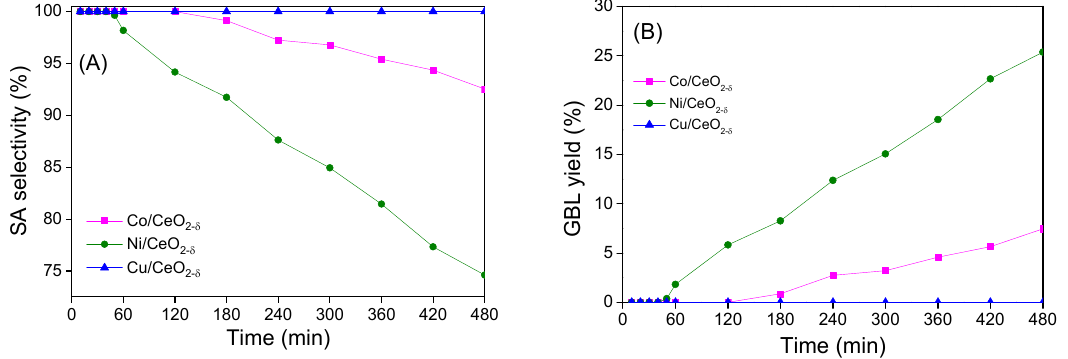
Figure 8. ( A ) The selectivity of succinic anhydride (SA) and ( B ) the yield of γ -butyrolactone (GBL) over M/CeO 2 −δ catalysts in the 8 h time.